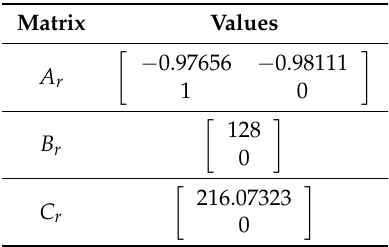
Figure 15. Comparison between the linear and nonlinear WECs in a regular wave: phase plot. Table 1. Radiation damping force